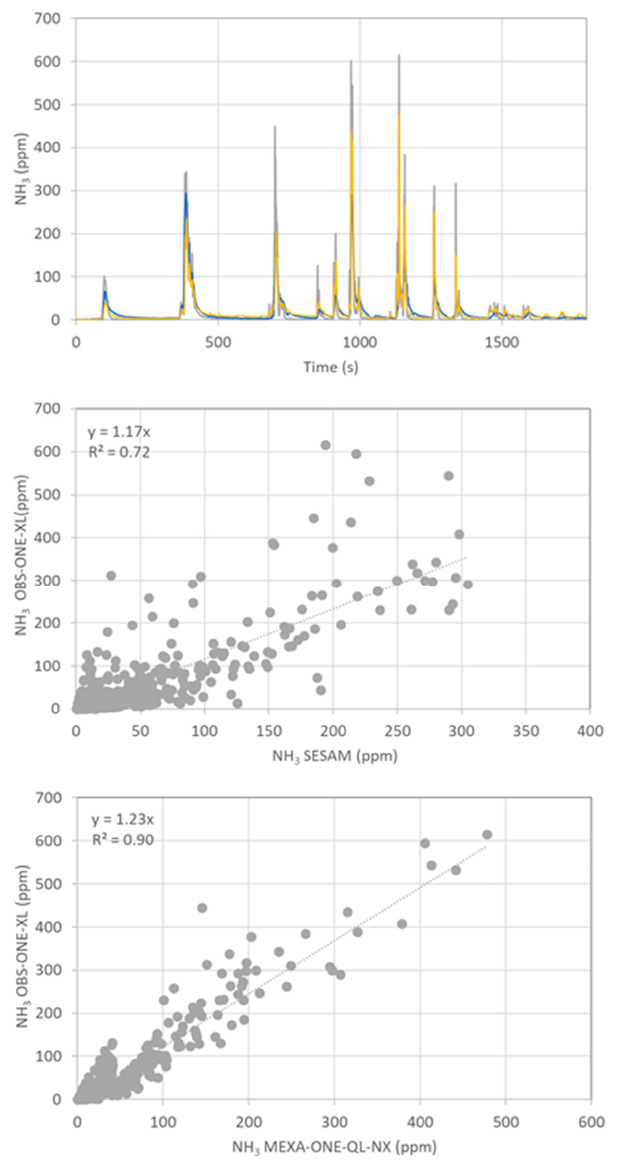
Figure 5. ( Top panel ) NH 3 emission profiles measured using the SESAM (blue), the OBS-ONE-XL (grey) and the MEXA-ONE-QL-NX (yellow) over the WHVC at 35 °C. Correlation of the NH 3 concentrations measured by the OBS-ONE-XL plotted against that measured by the SESAM ( central panel ) and against the MEXA-ONE-QL-NX ( bottom panel ).